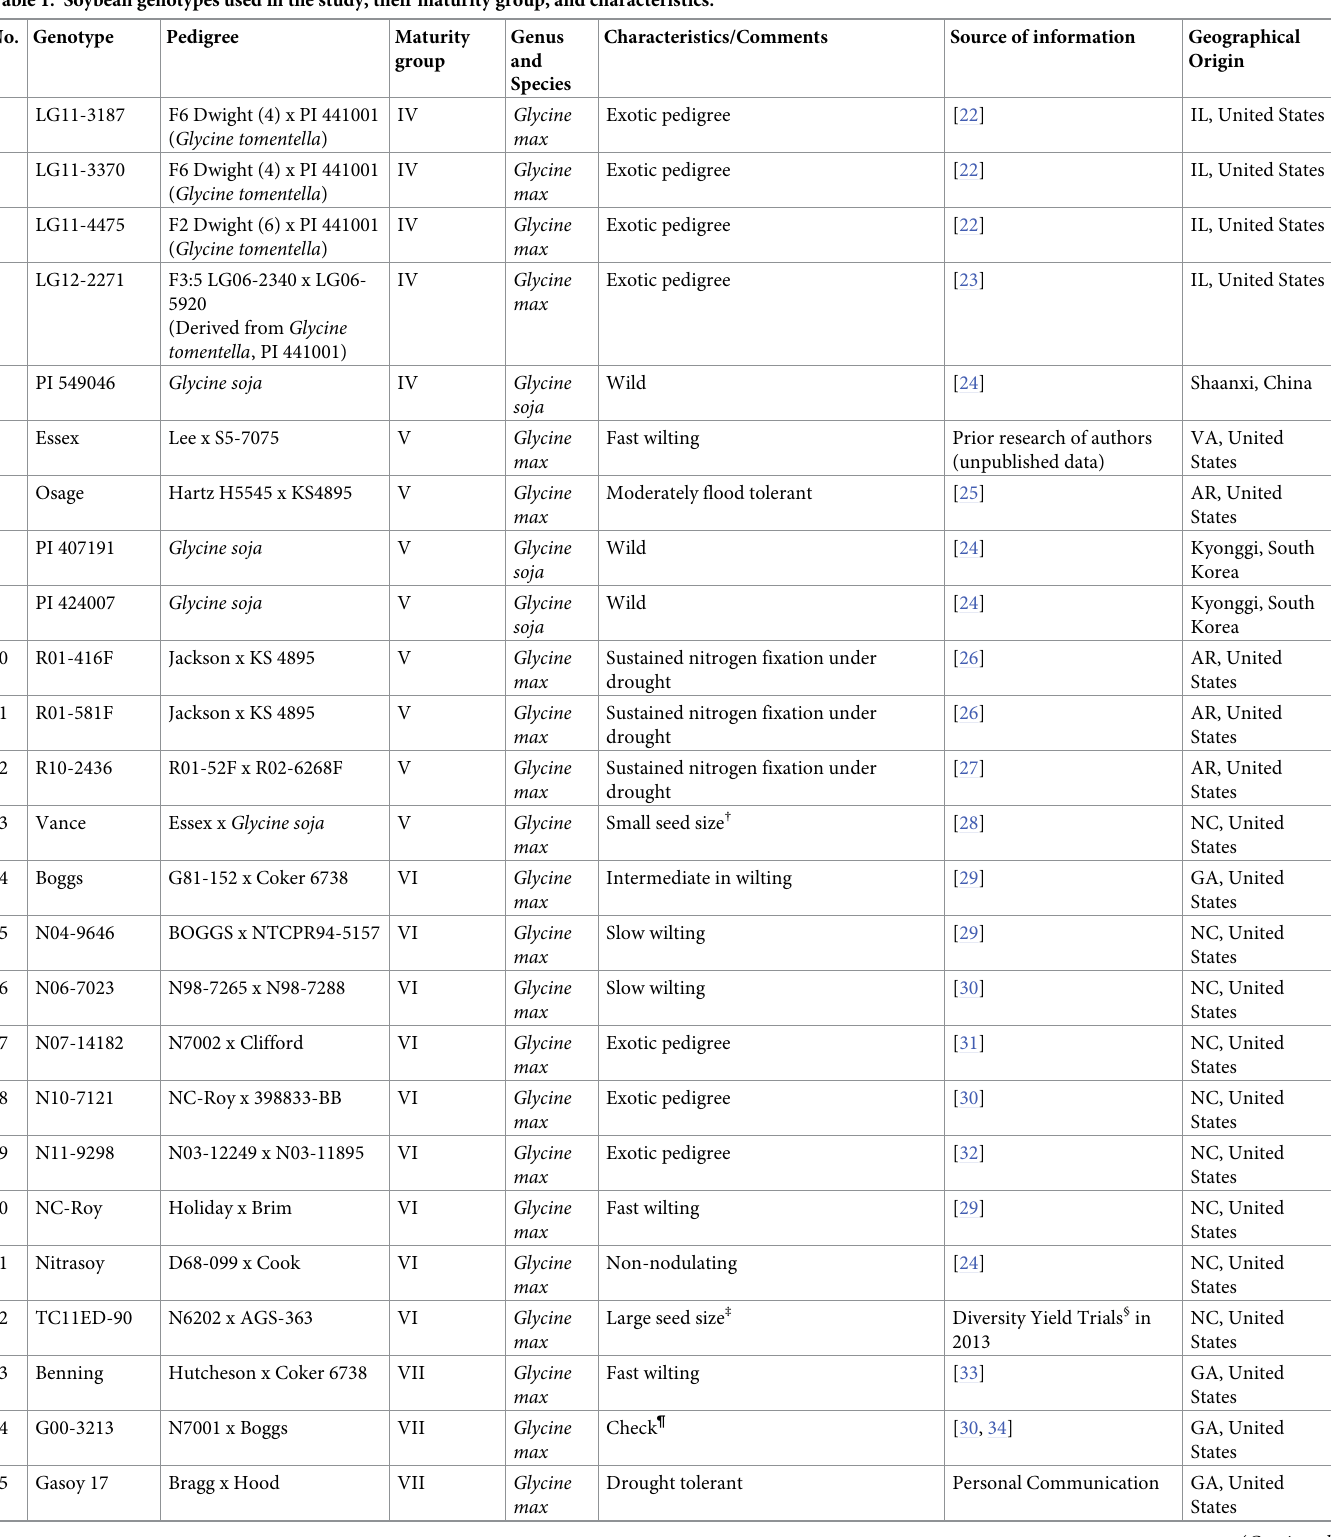
Table 1. Soybean genotypes used in the study, their maturity group, and characteristics. No.